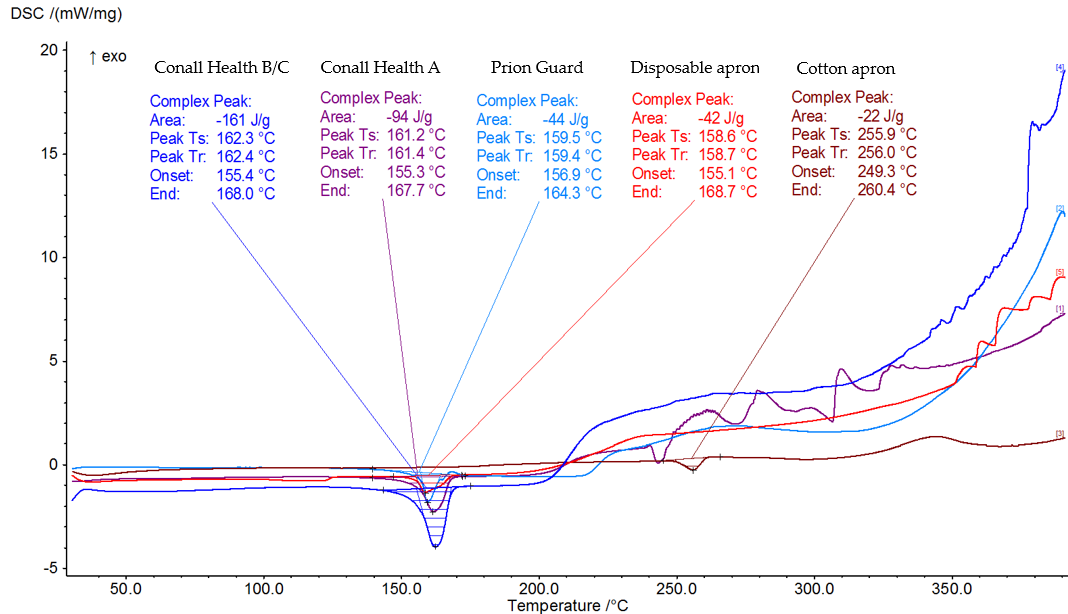
Figure 3. Differential scanning calorimetry curves of all studied fabrics in a nitrogen